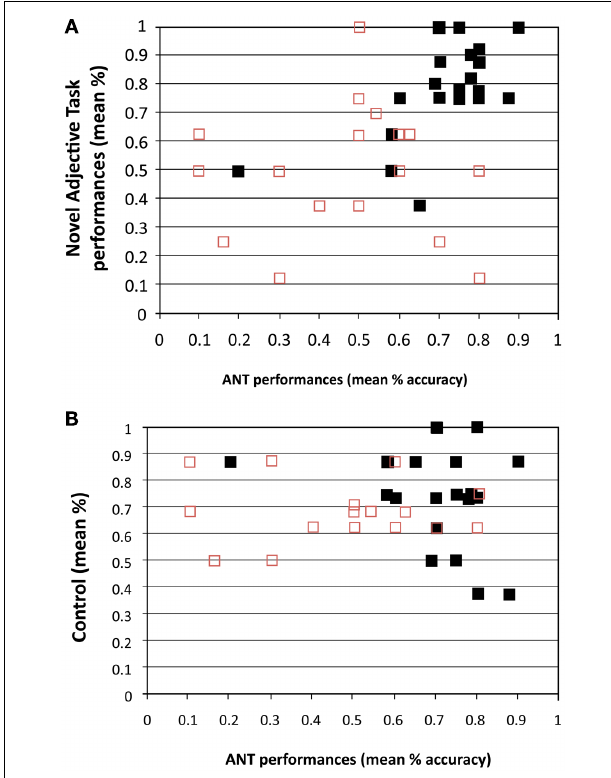
FIGURE 5 | Scatter plots showing individual subjects’ Monolingual (non-solid) and bilingual children’s (solid) performance onANT performances (accuracy) andAdjective learning task (A) and onANT performances (accuracy) and Control task